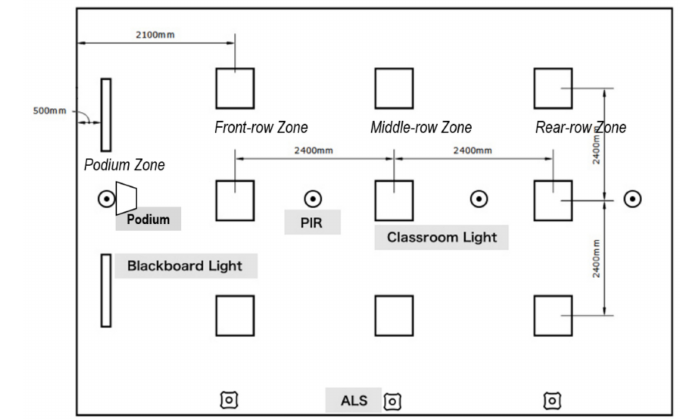
Figure 20. Standard classroom layout.